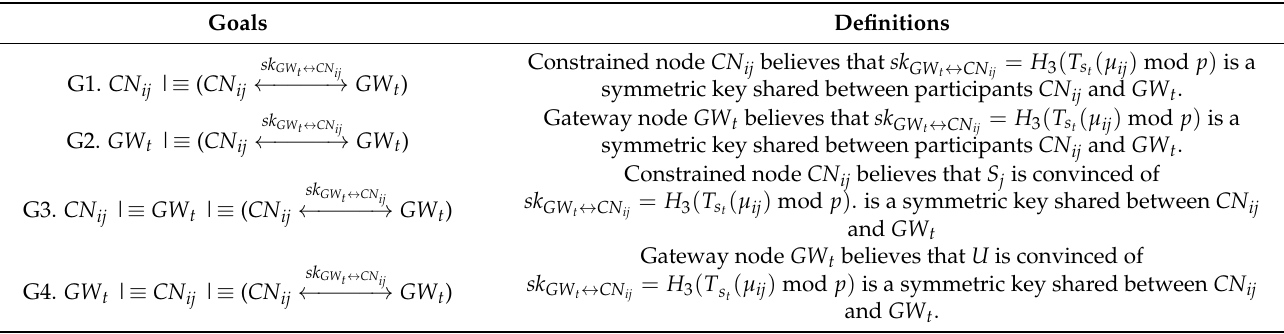
Table 3. Goals of the proposed